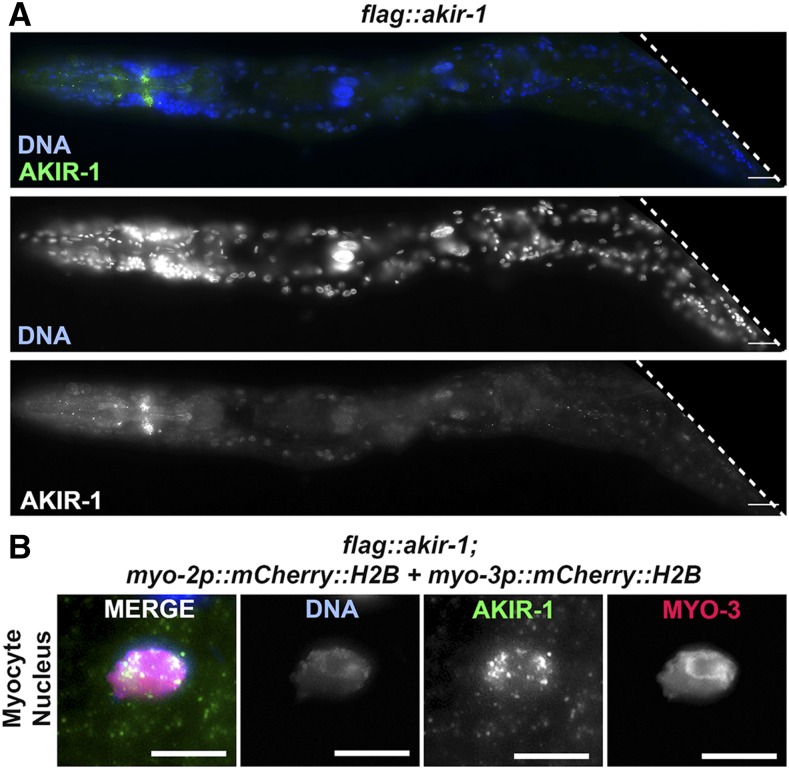
AKIR-1 is localized to somatic nuclei, including that of muscle cells. A) Whole body staining of wild type C. elegans for DAPI (blue) and AKIR-1 (green, anti-FLAG) (top) and DAPI and AKIR-1 channel separately (middle and bottom respectively). B) Myocyte nucleus with mCherry::MYO-3 (red) stained for DAPI (blue) and AKIR-1 (green, anti-FLAG), and single channels from left to right showing localization patterns of DAPI, AKIR-1, and MYO-3. Scale bars 2μm.